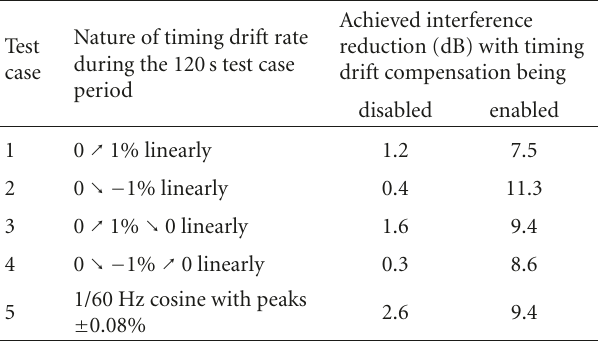
Table 1: DCAF’s performance without and with timing drift compensation—simulated